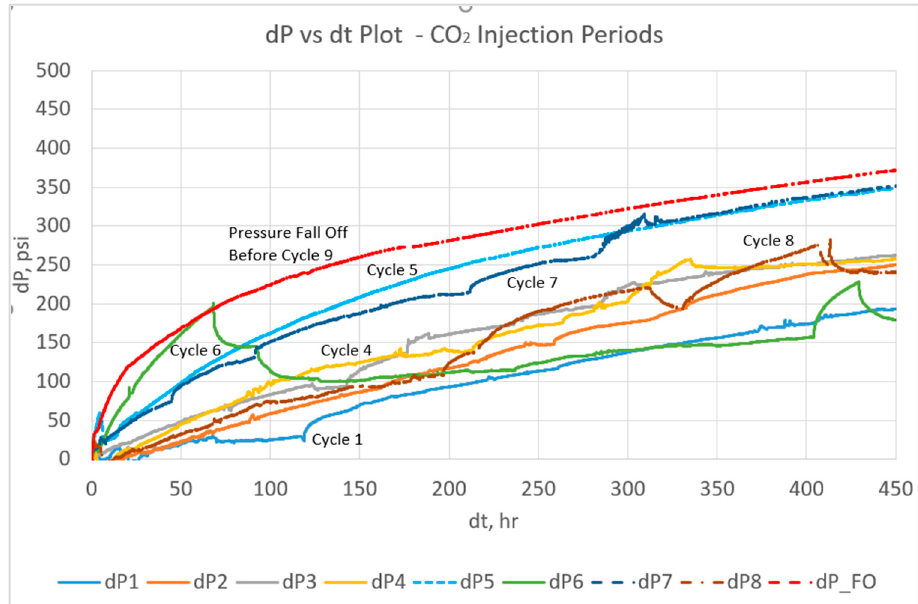
Figure 10. Transient analysis of CO 2 injection periods for the first 8 cycles. Additionally, the pressure fall-off results before Cycle 9 are shown.